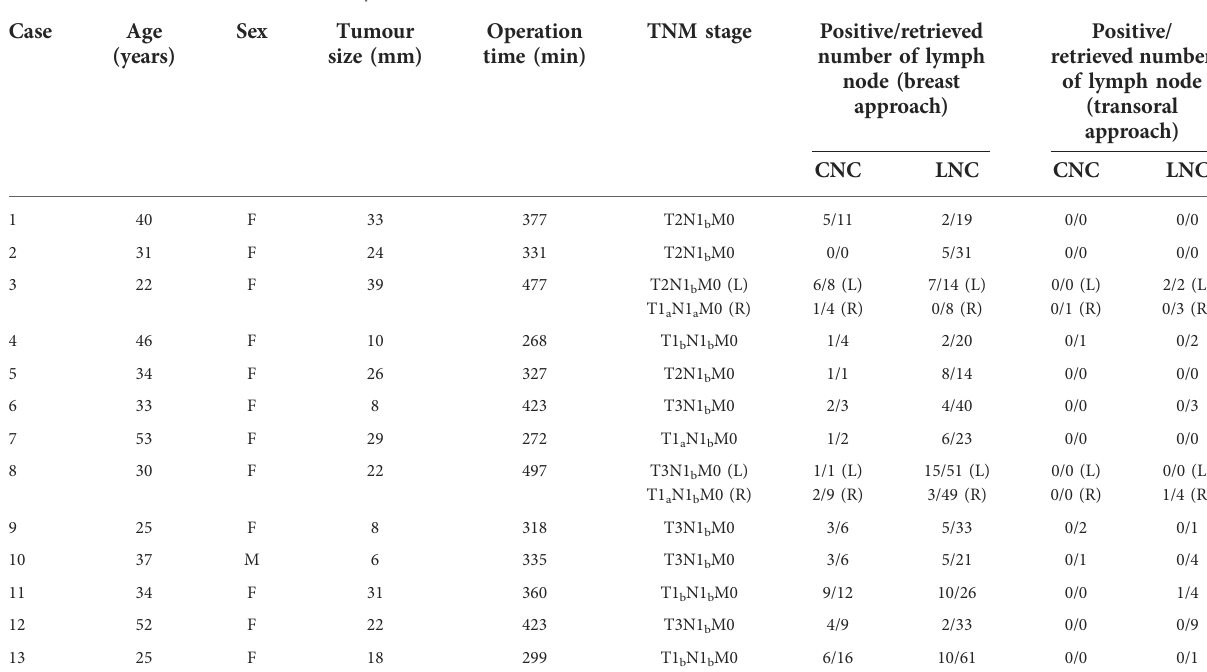
TABLE 1 The clinical characteristics of the patients ( n =13).